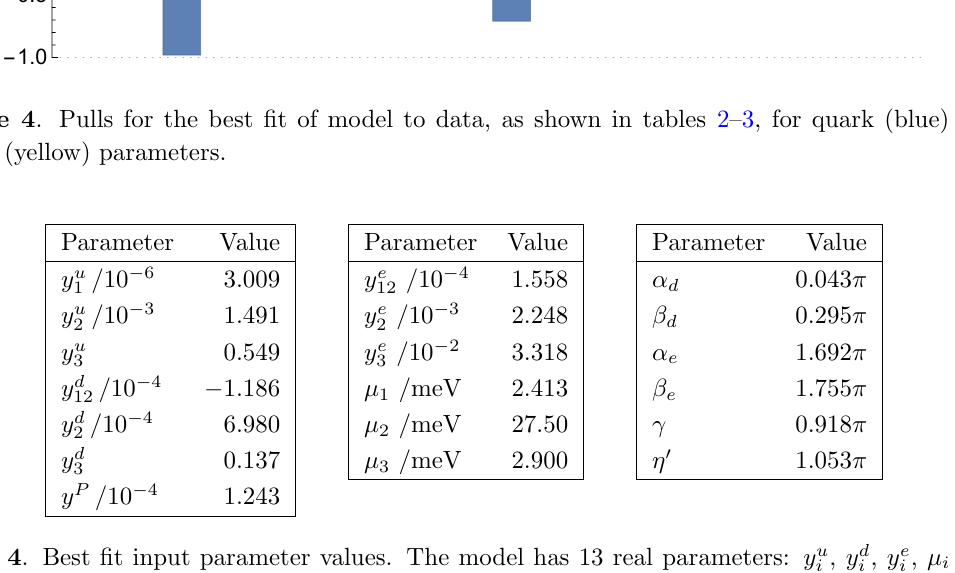
, y d , y e , (cid:22) i and i i i